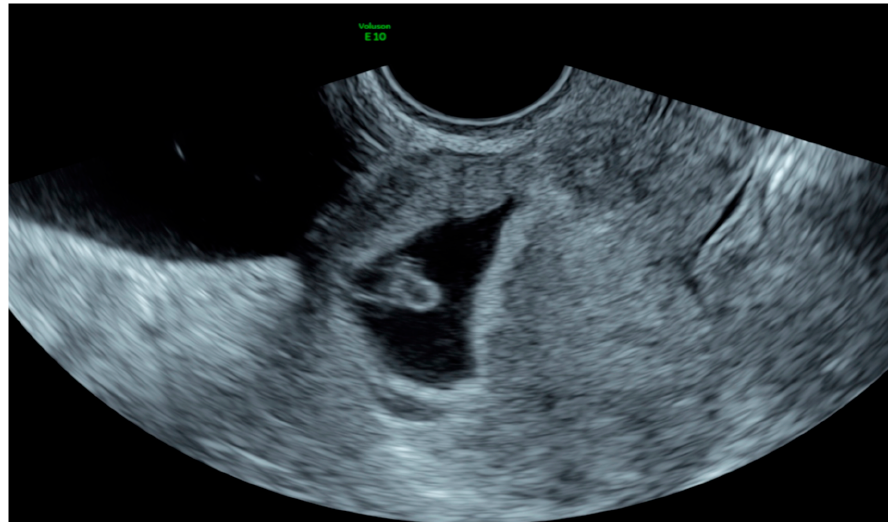
Figure 4. 2D Transvaginal image of a scar pregnancy. No fetal parts in the uterus or cervix, the presence of a GS in the anterior isthmic portion covering the scar site, entirely embedded within the myometrium and absence of contact between the bladder and GS.